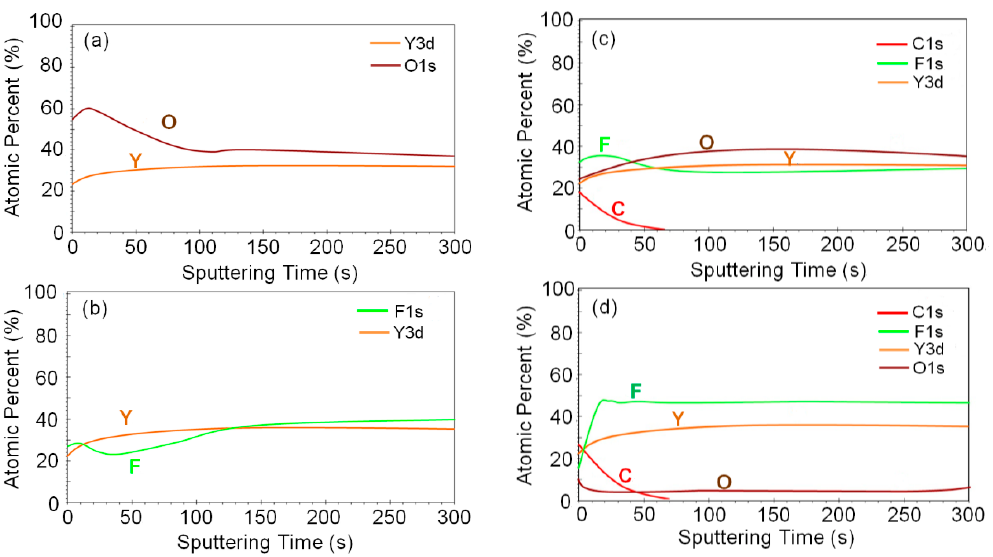
Figure 4. Variations of chemical compositions measured using X-ray photoelectron spectroscopy (XPS) with the sputtering time of ( a , c ) the Y 2 O 3 and ( b , d ) the YF 3 coatings before and after exposure to the fluorocarbon plasma.